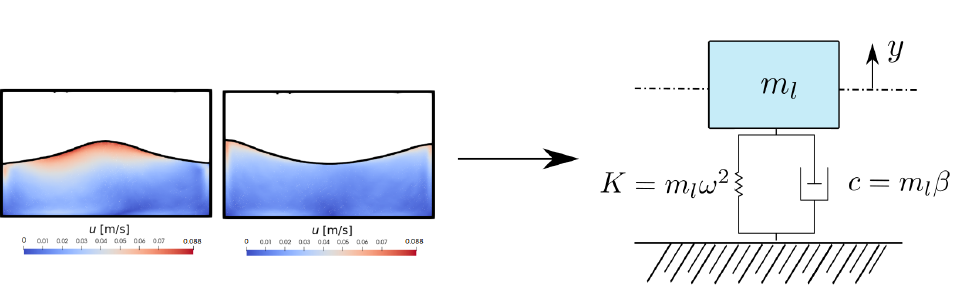
Figure 12. ( Left ): Snapshots of the velocity contour for two instant separated half periods. ( Right ): Mechanical analogy of the standing